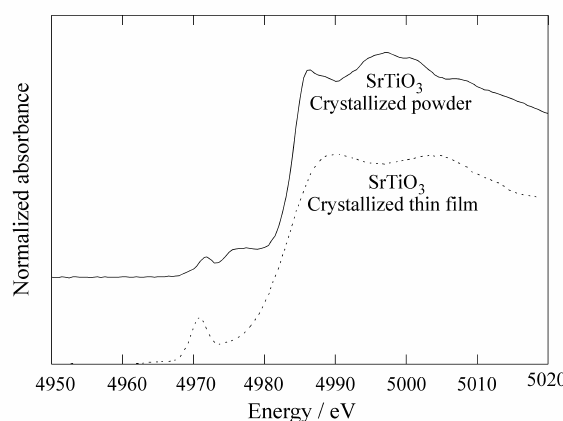
Figure 3. Ti K-edge XANES spectra of SrTiO 3 crystallized thin film compared to the SrTiO 3 amorphous thin films.